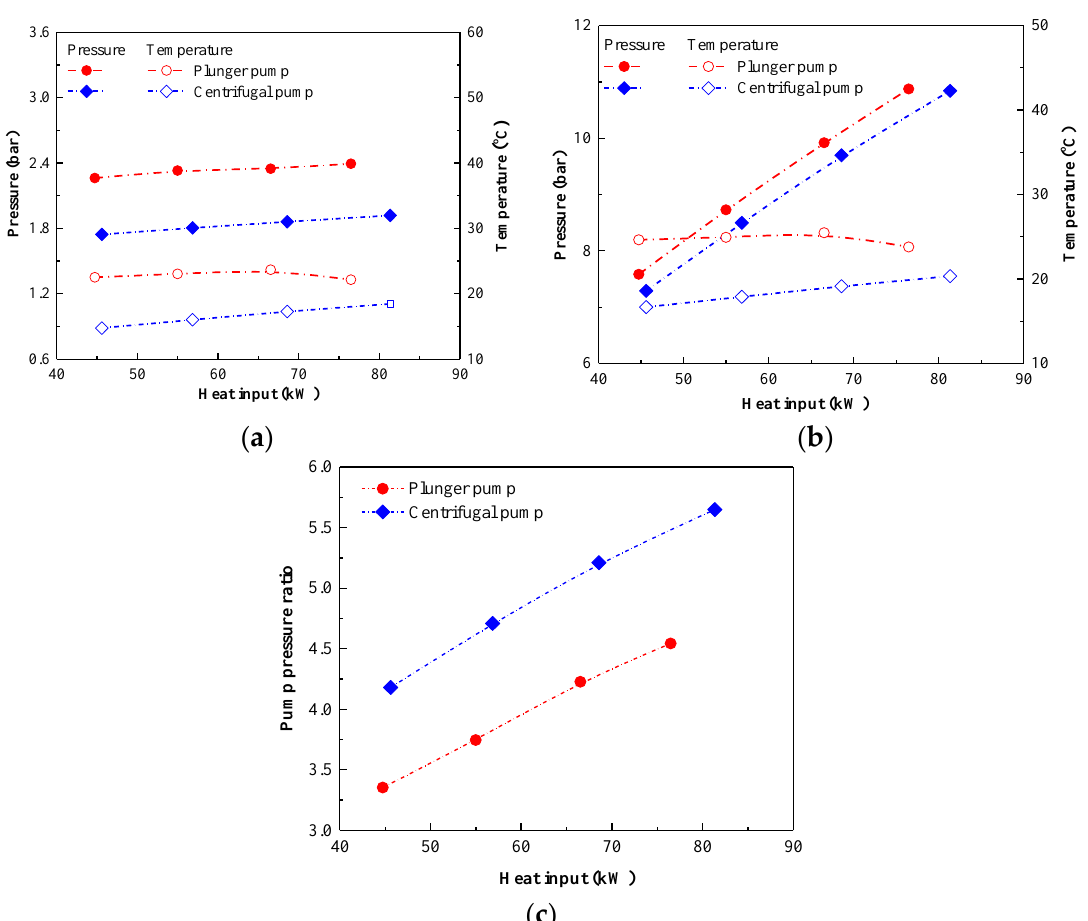
Figure 5. Pressure and temperature at the pump inlet and outlet with heat input using the plunger pump and centrifugal pump: ( a ) pressure and temperature at the pump inlet; ( b ) pressure and temperature at the pump outlet and ( c ) pump pressure ratios.